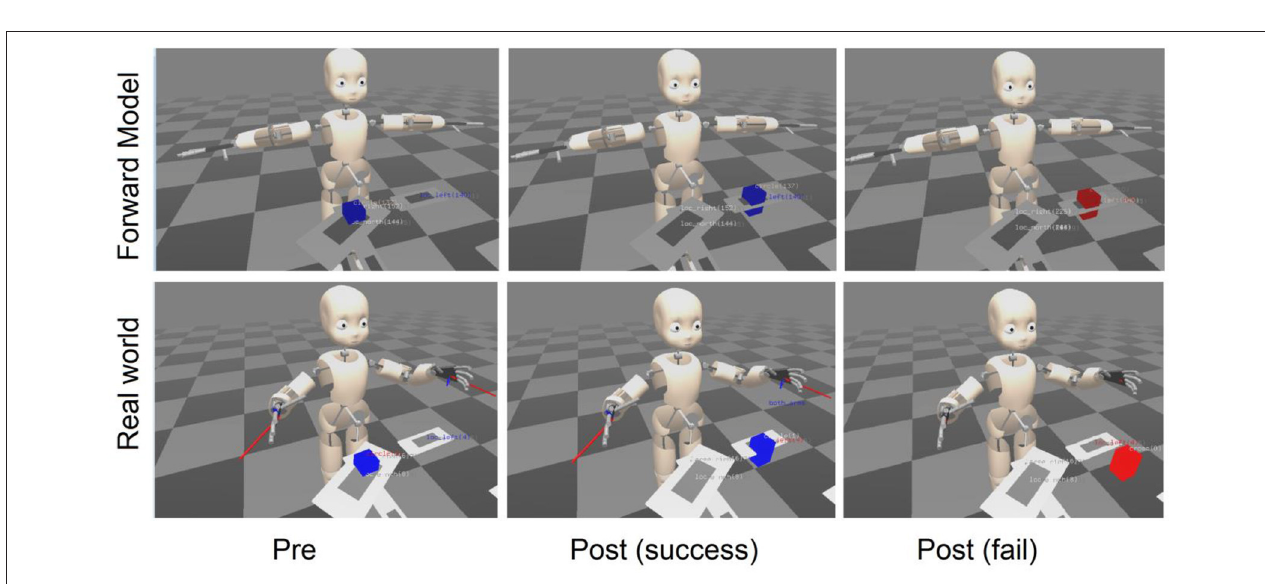
FIGURE 6 | Use of the mental simulation as forward model in the case of the action “put-object-left” where center column in blue is a success and right columns in red is a failure. Mental image (Forward Model) and actual physical state (Real world) before and after the action in each case are represented. The action to perform is to put the object to the left of the robot in the delimited location. Pre—indicates the state prior to the action. Post (success) shows the predicted and observed view of the outcome that match. Post (fail) shows that the predicted forward model outcome does not match the actually perceived real world outcome, thus indicating that the action failed. (modified from Pointeau et al.,